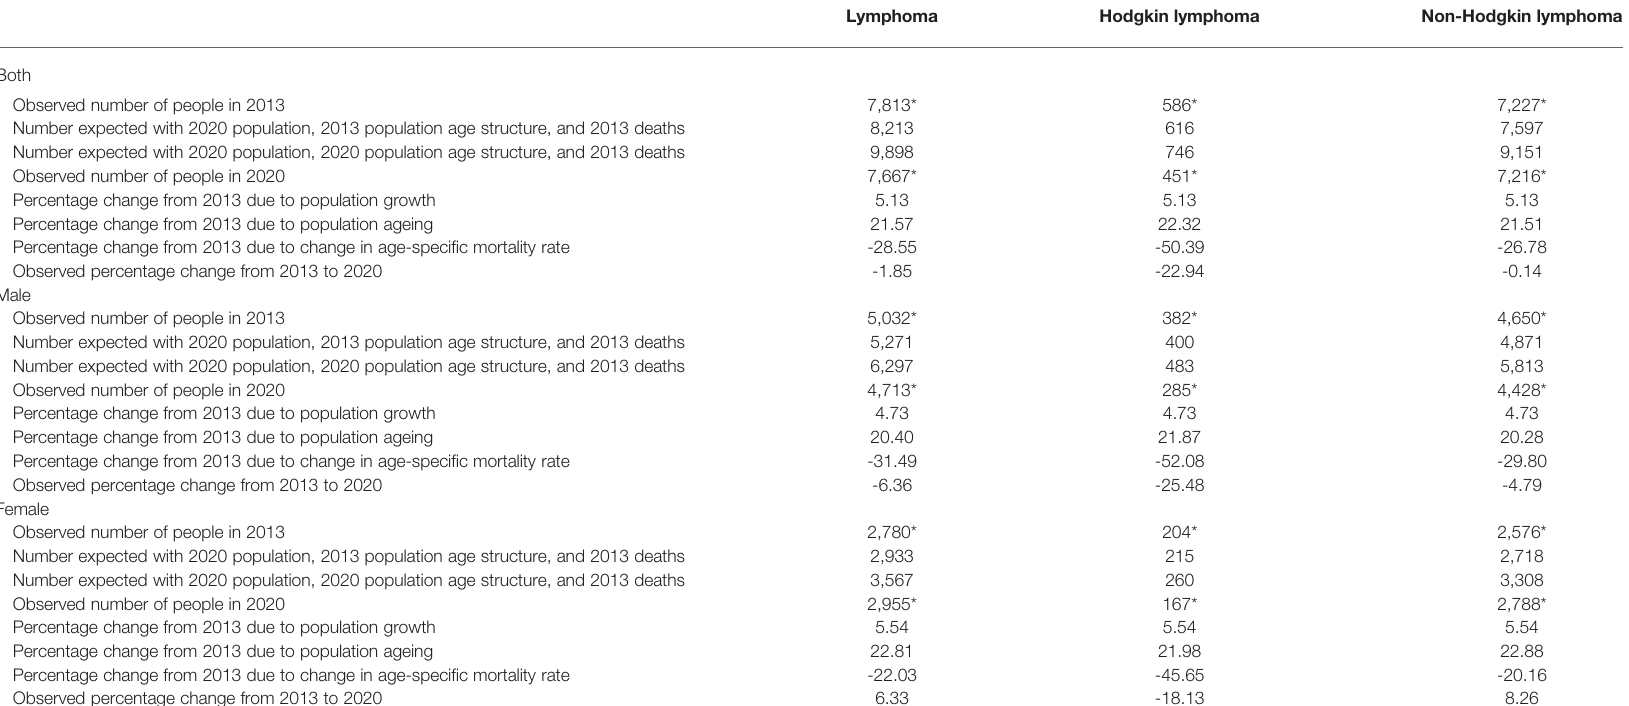
TABLE 4 | Decomposition of changes in lymphoma deaths from 2013 to 2020.